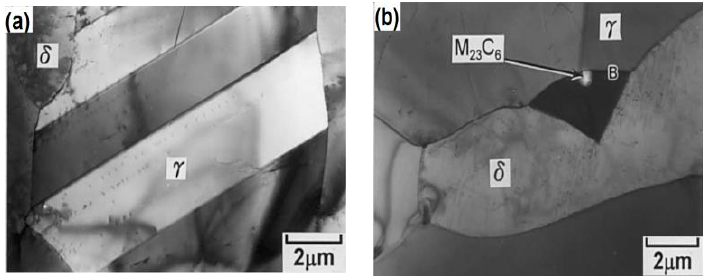
Figure 4. Transmission electron micrograph of duplex stainless steel: ( a ) as received; and ( b ) image of σ phase contained with a M 23 C 6 carbide particle after solution treated at 1080 °C [58].